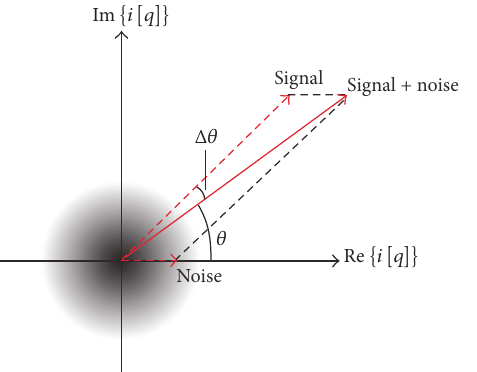
Figure 6: Schematic of the construction of the OCT phase in the 𝑧 - domain. The OCT signal is represented by the long arrow. A single noise realization is represented by the short arrow and is a vector from the Gaussian distributed noise around the origin. The OCT signal including the noise is constructed from the vectorial addition of the two contributions and leads to the variation Δ𝜃 of the angle 𝜃 .